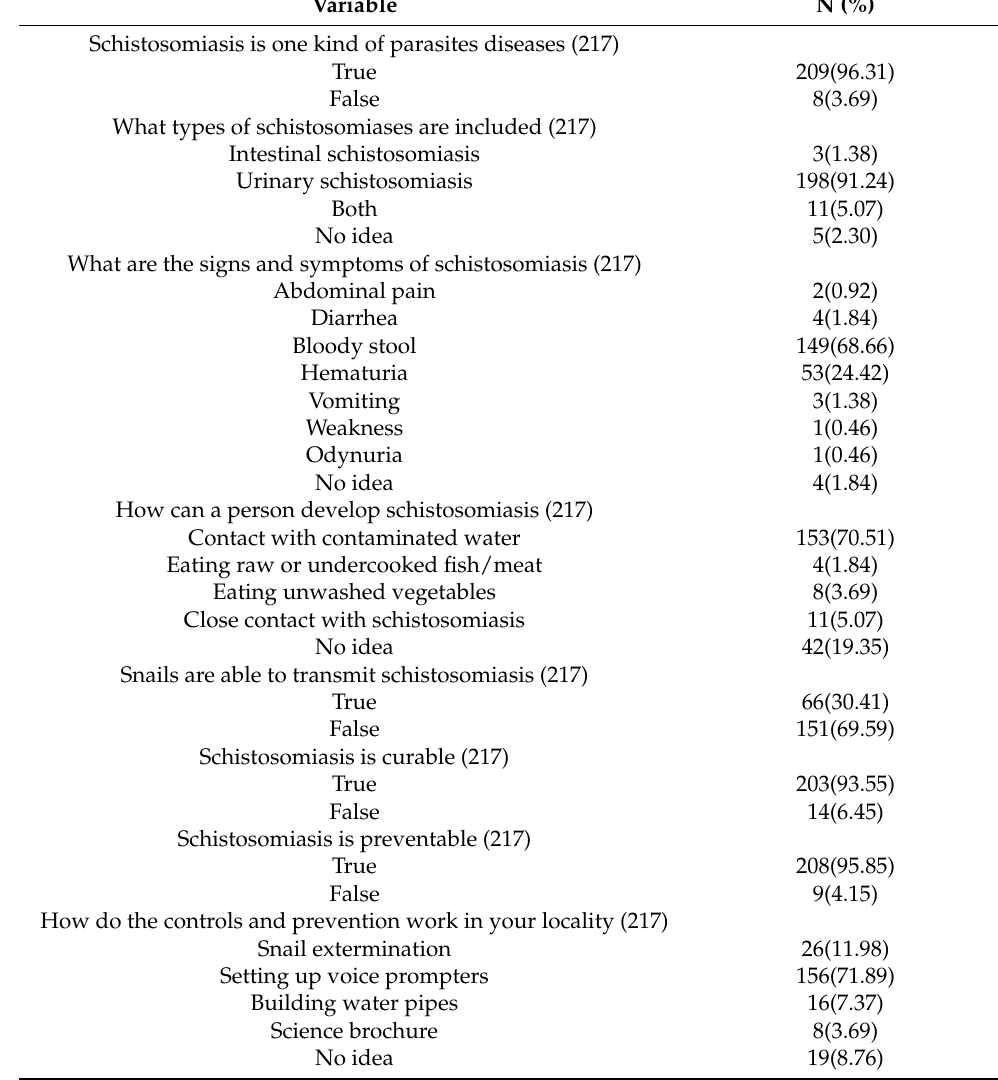
Table 2. Participants’ knowledge about